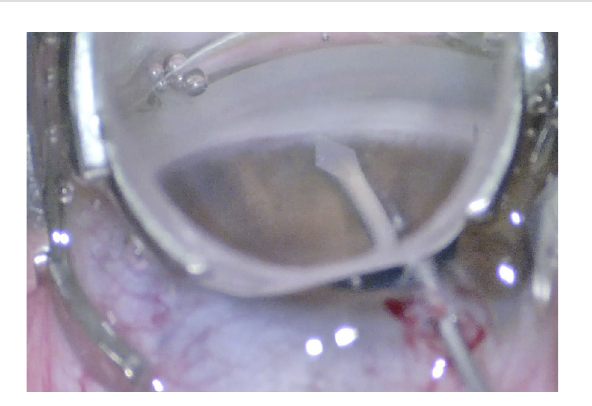
FIGURE 1 Goniotomy performed with a microvitreoretinal (MVR) blade in a patient with primary congenital